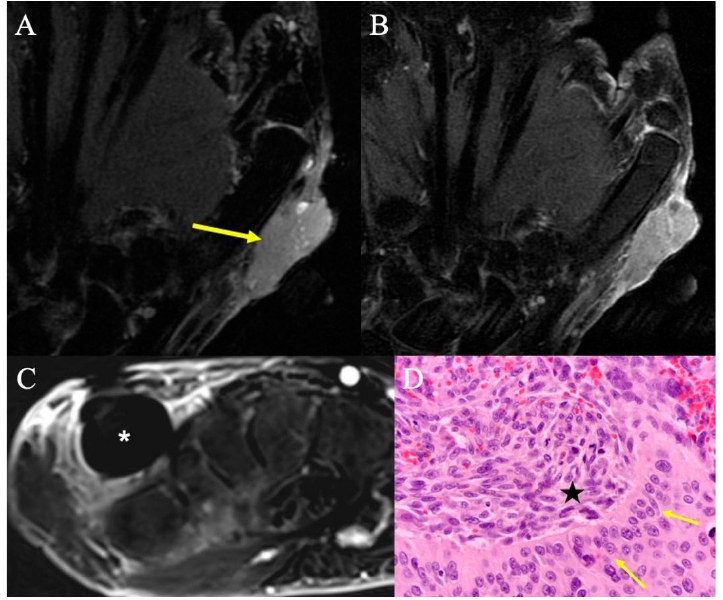
Figure 15. Carcinosarcoma. ( A ) Coronal fat-suppressed T2-weighted image showing a homogenous mass nearly isointense to muscle, radial to the first metacarpal (arrow). ( B ) Coronal contrast-enhanced fat-suppressed T1-weighted imaging shows mildly heterogeneous enhancement of this solid mass that involves the skin and subcutis. Biopsy confirmed carcinosarcoma of the hand. ( C ) Contrast-enhanced fat-suppressed T1-weighted image with subtraction from routine surveillance MRI 12 months after surgical resection revealed a 1.5 cm round mass (*) in the dorsal aspect of the surgical resection bed; despite lack of central enhancement, the morphology and timing of the imaging findings raised concern for recurrent disease, which was subsequently proven by percutaneous needle biopsy. ( D ) High-powered H&E showing the sharp demarcation between the squamous cell component (arrows) and spindle-shaped cells (*) characteristic of carcinosarcoma of the